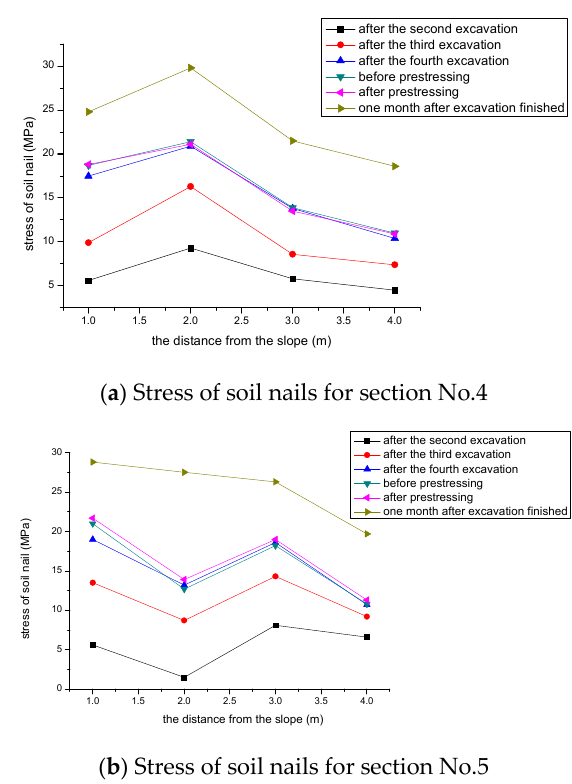
( b ) Stress of soil nails for section No.5 Figure 15. The distribution of nail forces of the first row for sections No. 4 and No. 5.